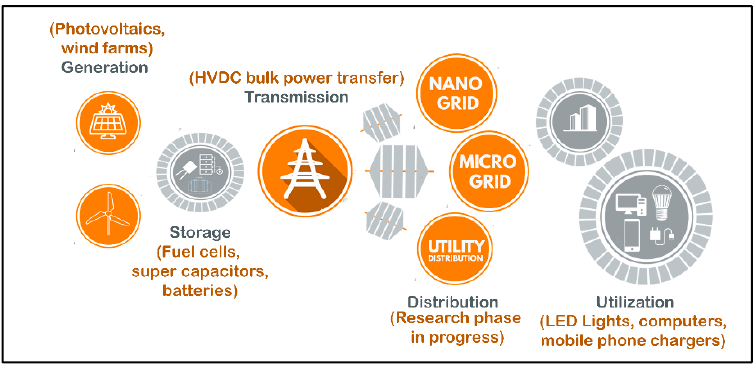
Figure 1. DC in the Power System.